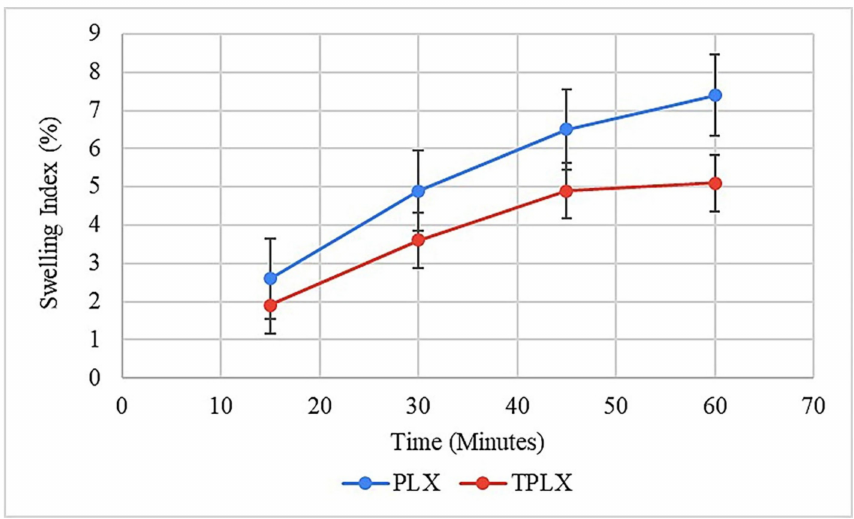
Figure 7. Swelling index of PLX- and TPLX-based tablets of TCM.